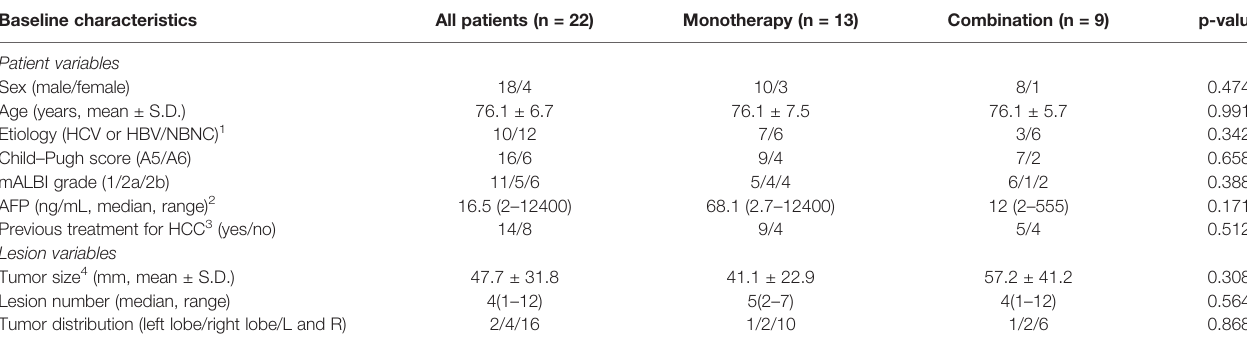
TABLE 1 | Patient and lesion characteristics at the time of study entry. Baseline